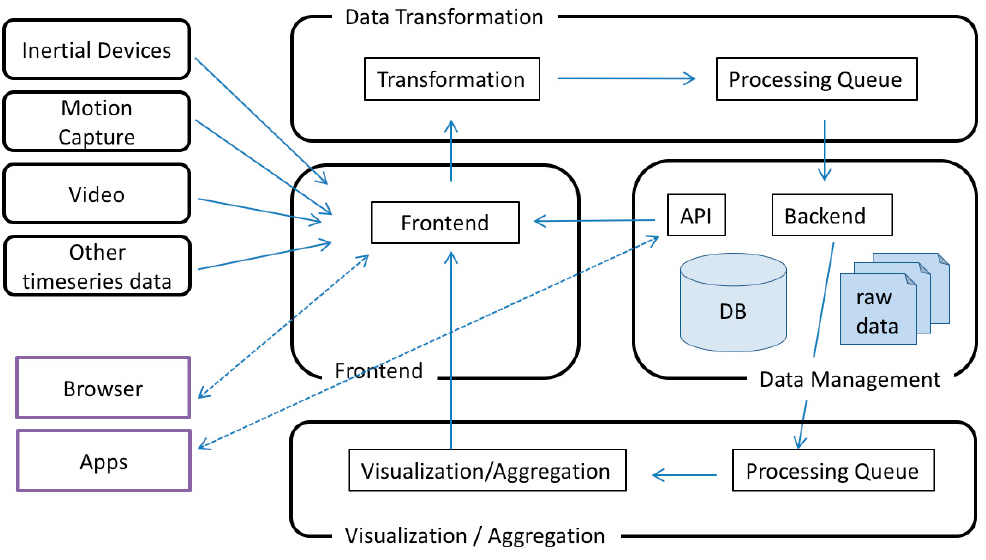
Figure 2. Visualisation of a typical user workflow and application for aggregation of inhomogeneous datasets.